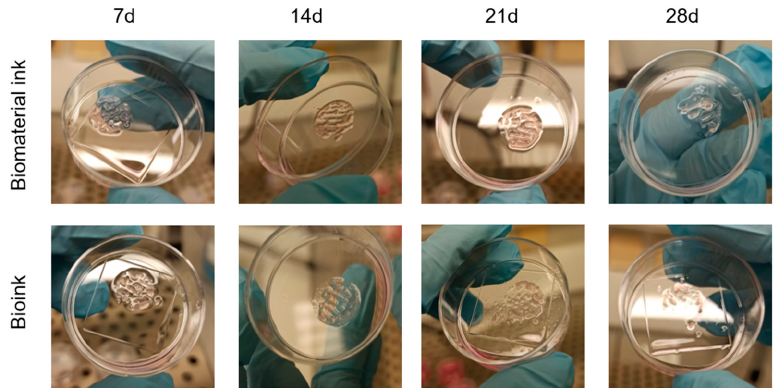
Figure 5. Comparison between the constructs printed with biomaterial ink and bioink at different time points after printing. The impact of the UMR-106 cells on the maintenance of the 3D structure over time was further investigated using a concentration of 2 × 10 6 cells/mL, which was an intermediate value between the previous those of the concentrations evaluated (7 × 10 5 and 6 × 10 6 cells/mL).